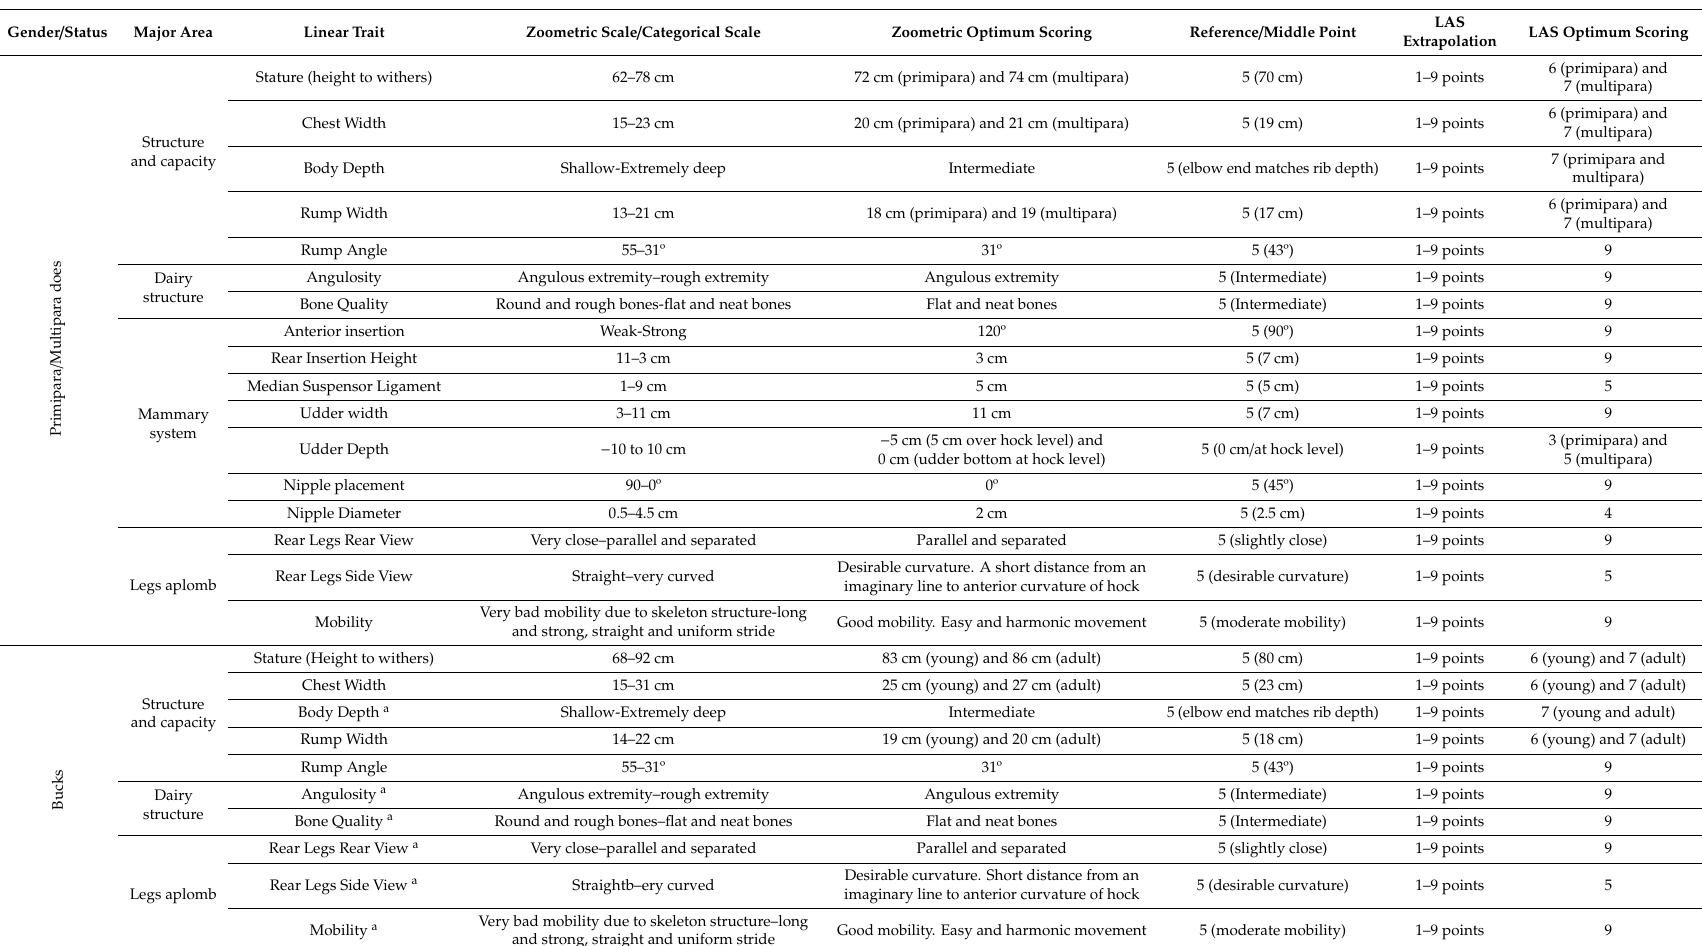
Table 1. Detailed description of the scales used and the translation process from zoometric traits to linear appraisal scoring system (LAS) scores in Murciano-Granadina goat and